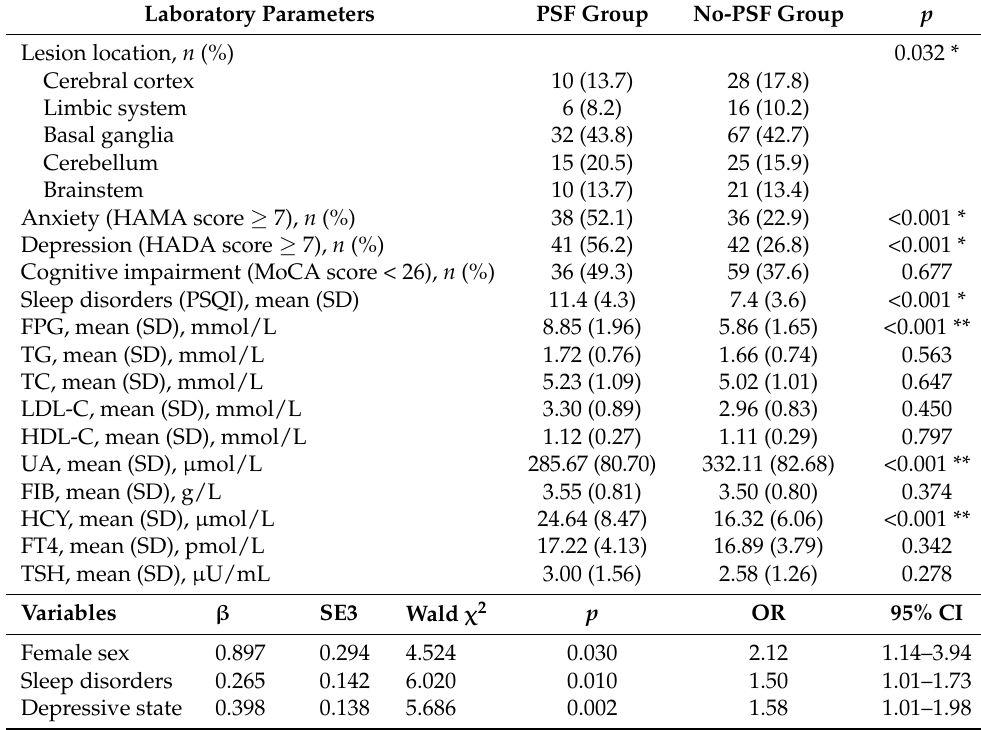
Table 2. Comparison and logistic regression analysis of biochemical data between the PSF and no-PSF